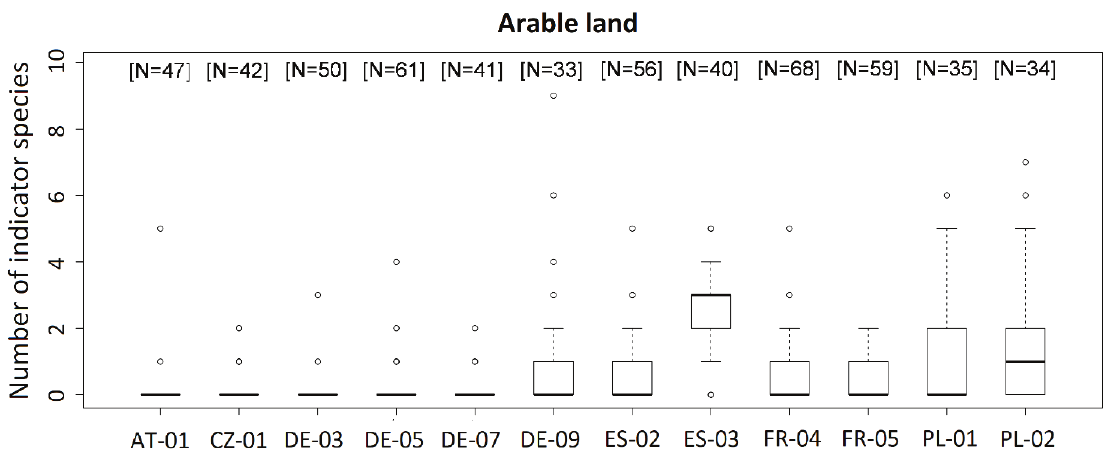
Figure 6. Number of indicator species in arable habitats in the 12 dominantly arable regions in 2016. Graph shows box whisker plots with medians, 25% quantiles, 75% quantiles, the lowest and highest data points still within 1.5 interquartile range and the extremes.